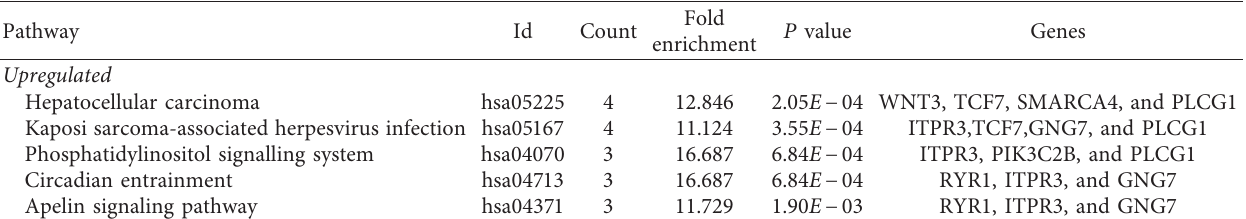
Table 4: KEGG pathway analysis of common upregulated DEGs.